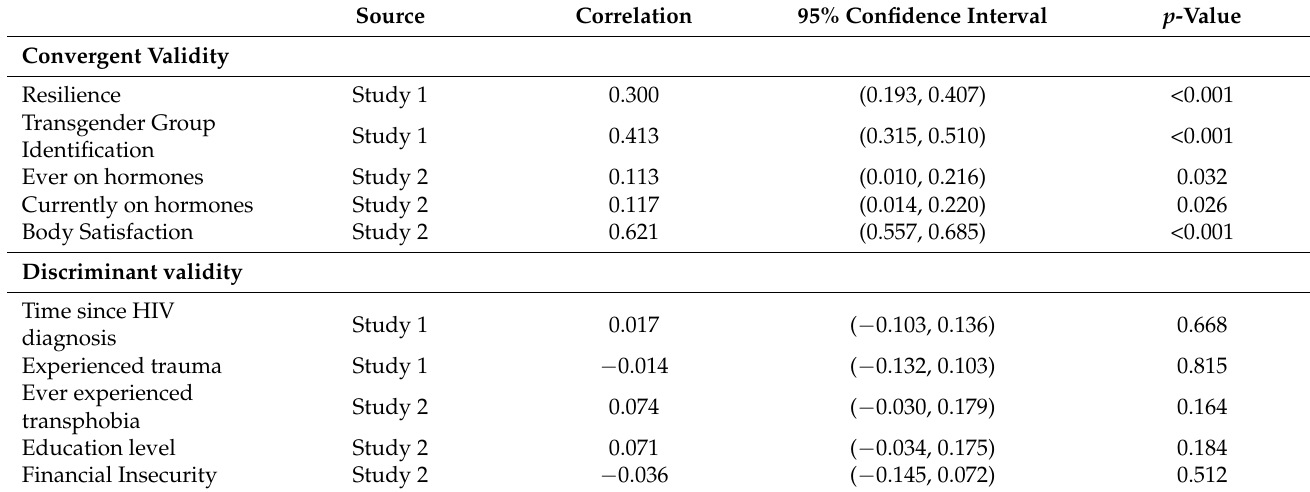
Table 3. Correlations of Psychological Gender Affirmation (PGA) with select study measures.